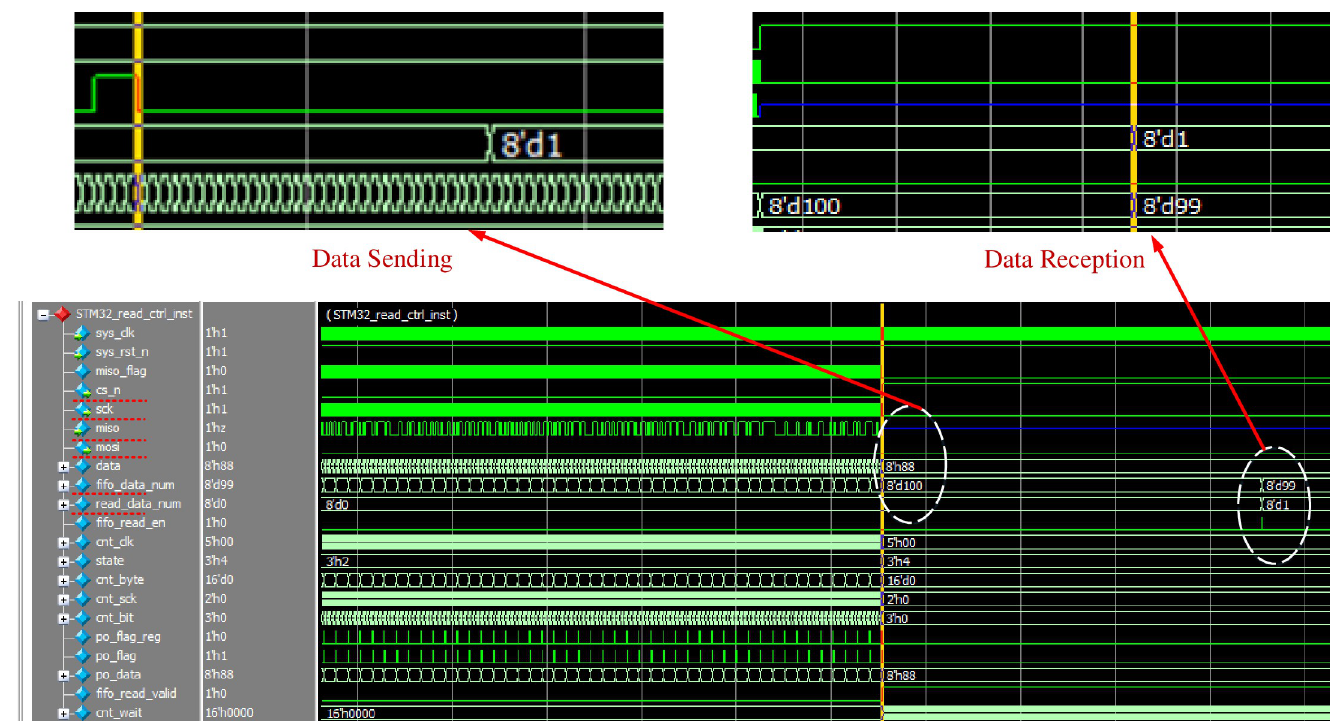
Fig 21. SPI communication simulation